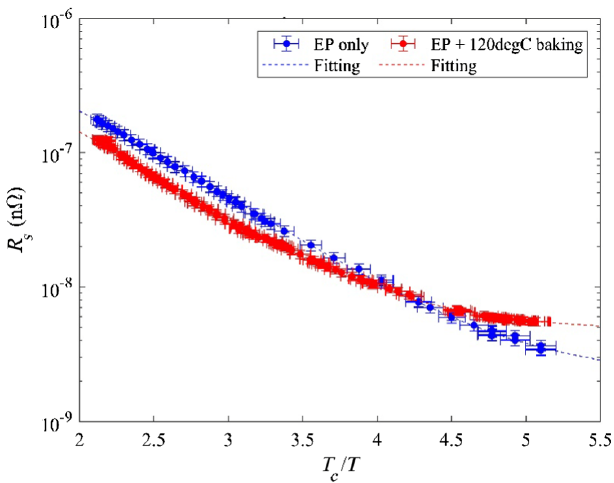
=T , where T ¼ 9 . 2 K, the c c of acc ¼ A ω 2 e − Δ KBT þ R 0 , where the T s ¼ 1 . 9 , k B T c ¼ 2 . 0 , k B T c